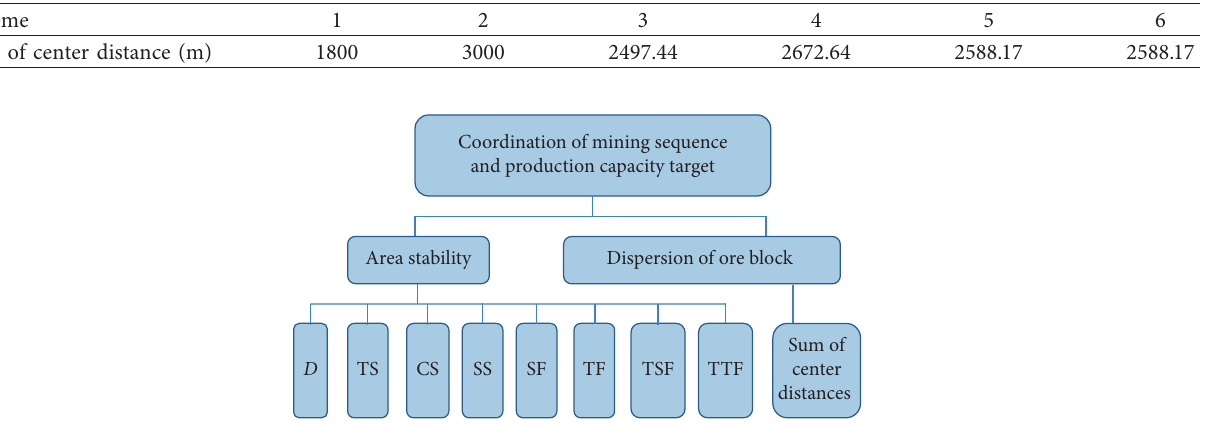
Figure 7: Collaborative model of mining sequence and production capacity target. Table 4: Score of the basic elements of the six schemes.